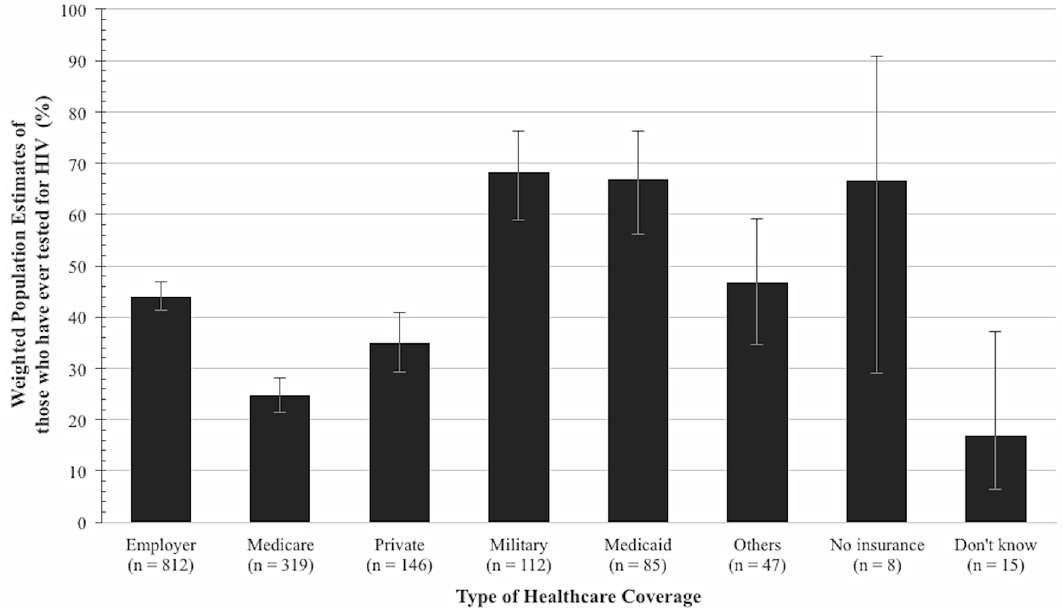
Figure 1. Weighted percentages of adults who have ever tested for HIV in Georgia based on the type of healthcare coverage: BRFSS 2014 data. Note: Error bars indicate 95% confidence intervals for each estimate.